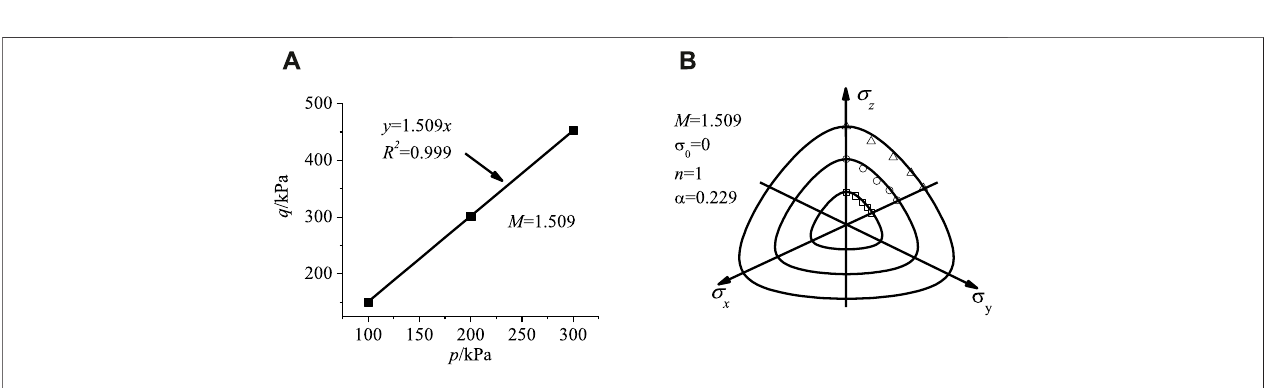
FIGURE 3 | UNS criterion variation (test data from Toyota et al.,